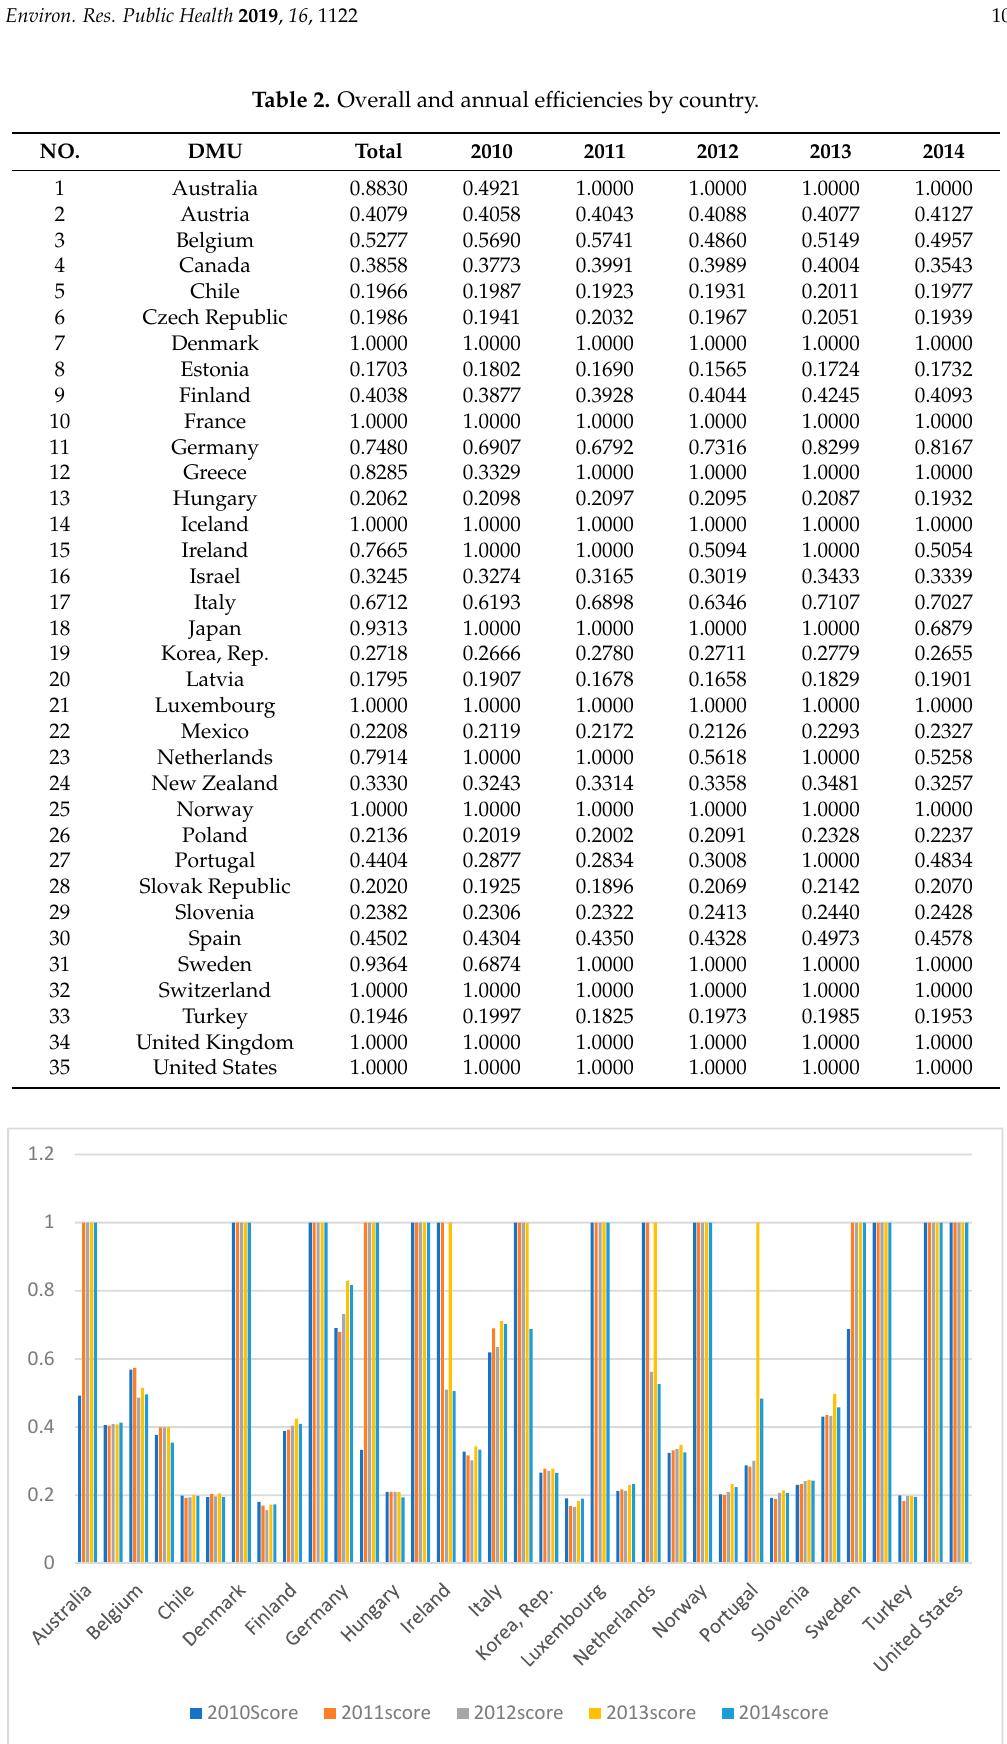
Figure 6: Overall and annual efficiencies by country Figure 6. Overall and annual efficiencies by